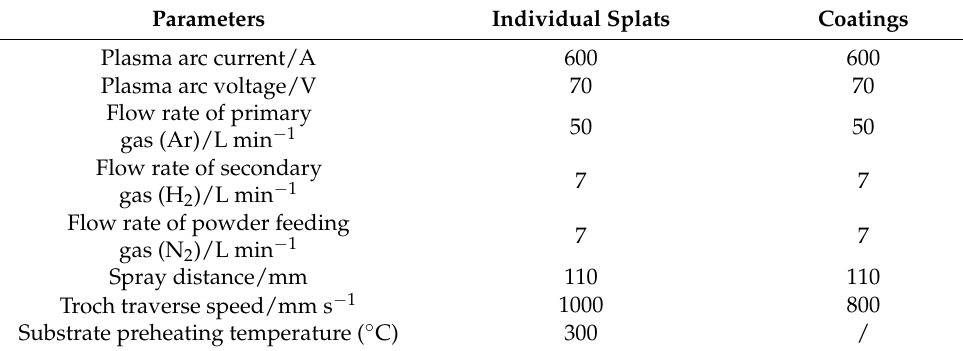
Table 1. Plasma spray parameters for individual splats and coatings. Parameters Individual Splats Coatings Plasma arc current/A 600 600 Plasma arc